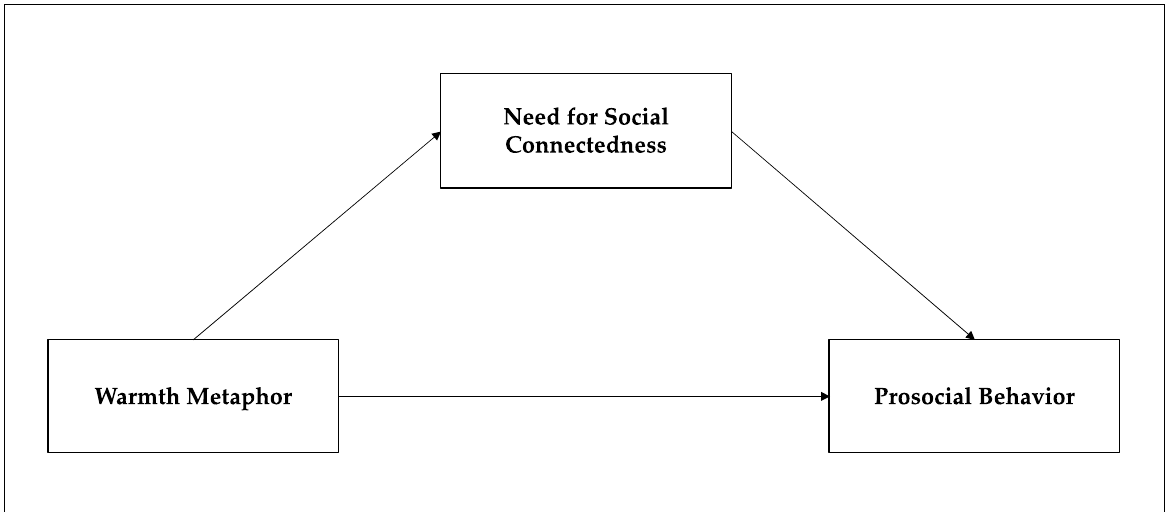
Figure 1. Conceptual Research